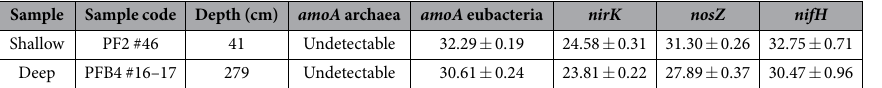
Table 1. Quantitative PCR results. Data show the RealTime threshold cycles recorded for the different amplifications. Data are the means of three technical replicates ± Standard